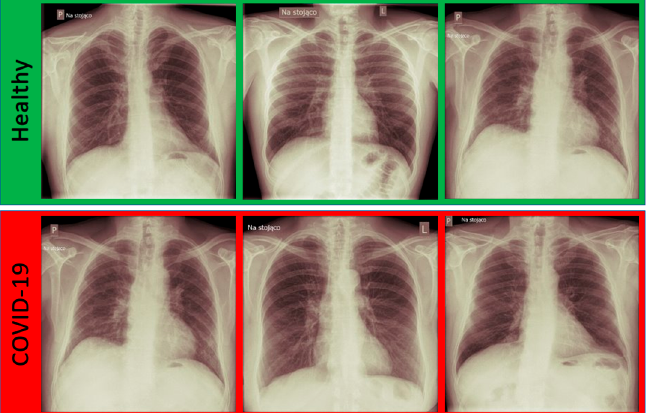
Figure 2. The exemplary images from the dataset divided into two classes: Healthy and COVID-19 confirmed by a PCR test.